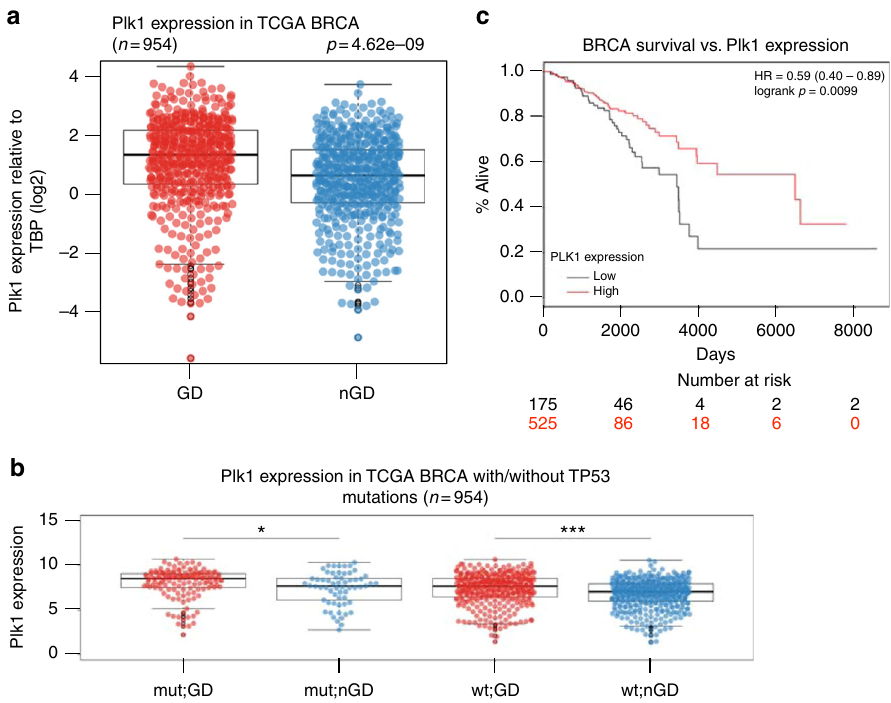
Fig. 8 Plk1 expression in human breast cancers. a Plk1 expression relative to TBP (log2) in genome-doubled (GD) and non-genome-doubled (nGD) breast cancers from the TCGA. p = 4.62e-09, t -test. b Plk1 expression in breast cancers with and without TP53 mutations. The association between GD and Plk1 expression is signi fi cant in TP53 wt tumors. p = 3.37e-06, t -test. c Survival analysis of breast cancer (BRCA) patients with low Plk1 expression (bottom quartile) and those with higher Plk1 expression (remaining quartile) p = 0.0099; hazard ratio (HR), 0.59; 95% con fi dence interval (CI), 0.40 –